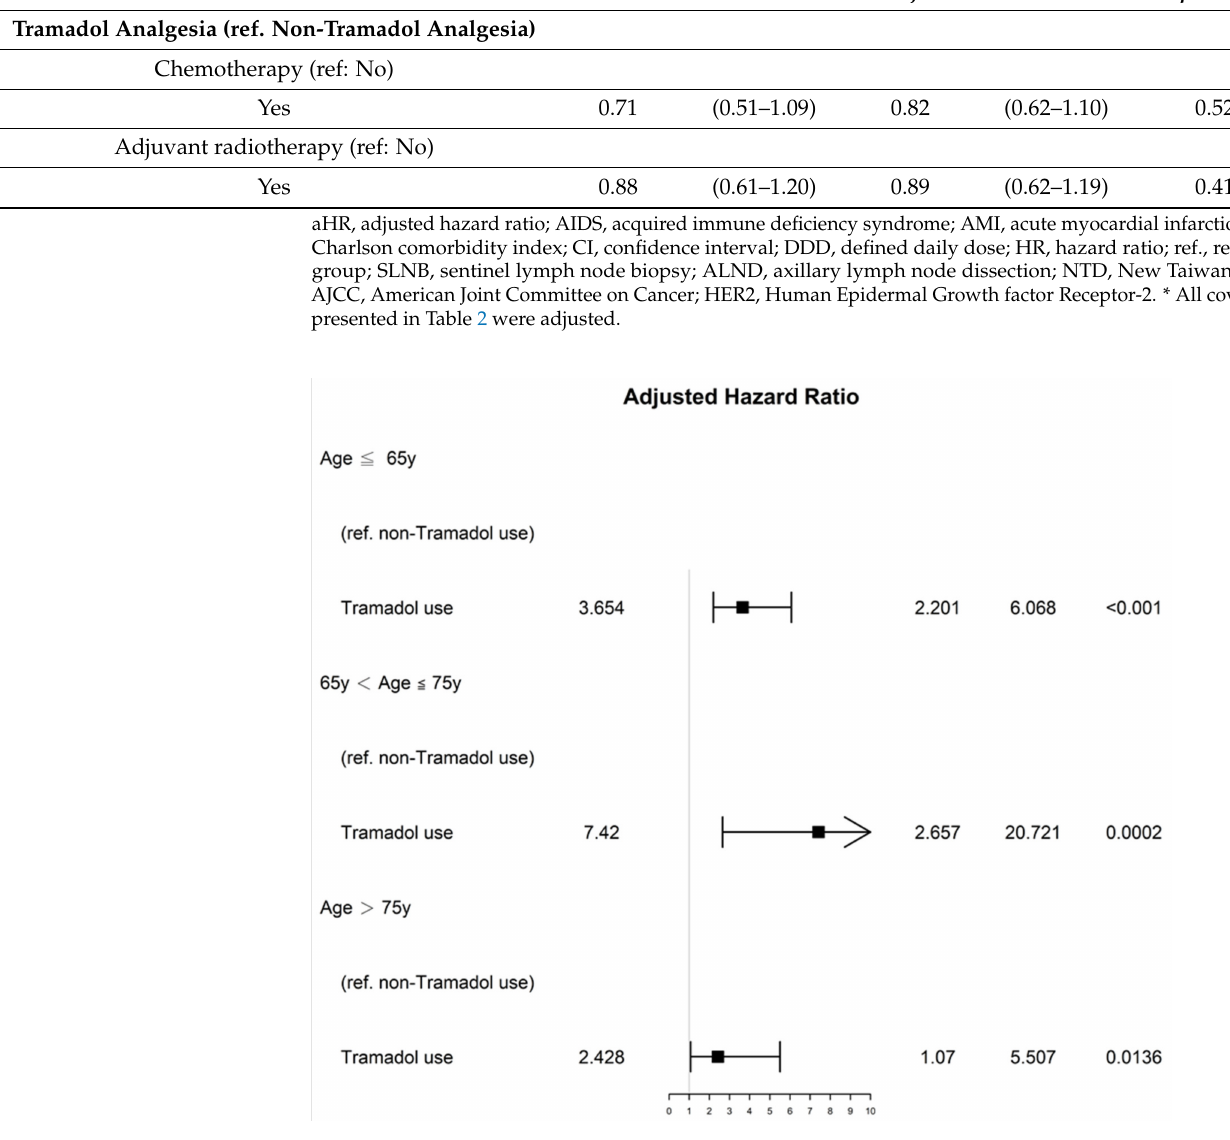
Figure 1. Forest plots of the adjusted hazards ratios for all-cause death in patients who received long-term tramadol analgesic therapy before breast cancer diagnosis compared with those who did not, stratified by age